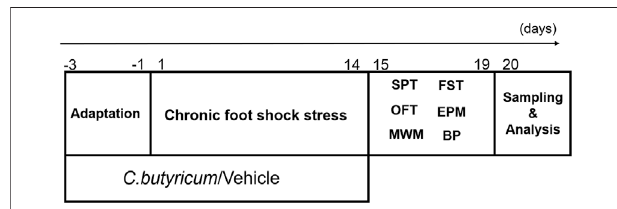
FIGURE 1 | The schematic diagram of the experiments. SD rats were pretreated with C. butyricum RH2 or vehicle for 3 days before receiving chronic foot shock stress for 14 days, and the rats treated with C. butyricum RH2 or vehicle for 17 days in total. Between days 15 and 20, the rats were given behavioral tests (15th – 16th day:SPT; 17th – 19th day:FST, OFT, EPM; 15th – 20th day:MWM). Blood and brain specimens were collected on the 20th day for further measurement and analysis. SPT, sucrose preference test; FST, forced swim test; OFT, open fi eld test; EPM, elevated plus maze test; MWM, Morris water maze; BP, blood